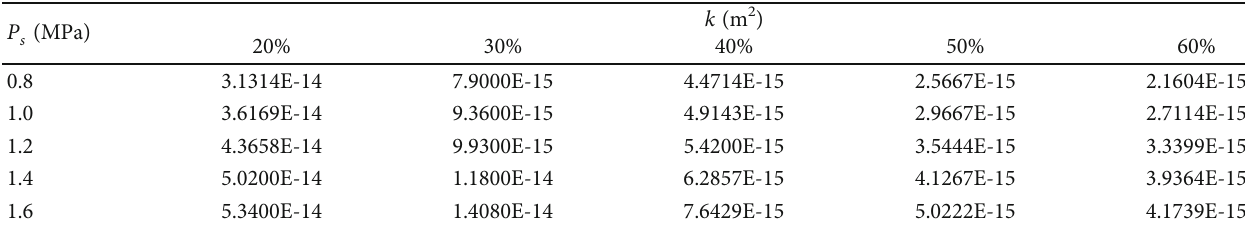
Figure 16: Microstructure of fragments with S = 20 % and S = 60 % . ff erent clay mineral proportions S Table 4: Variation of permeability k with osmotic pressure P s under di